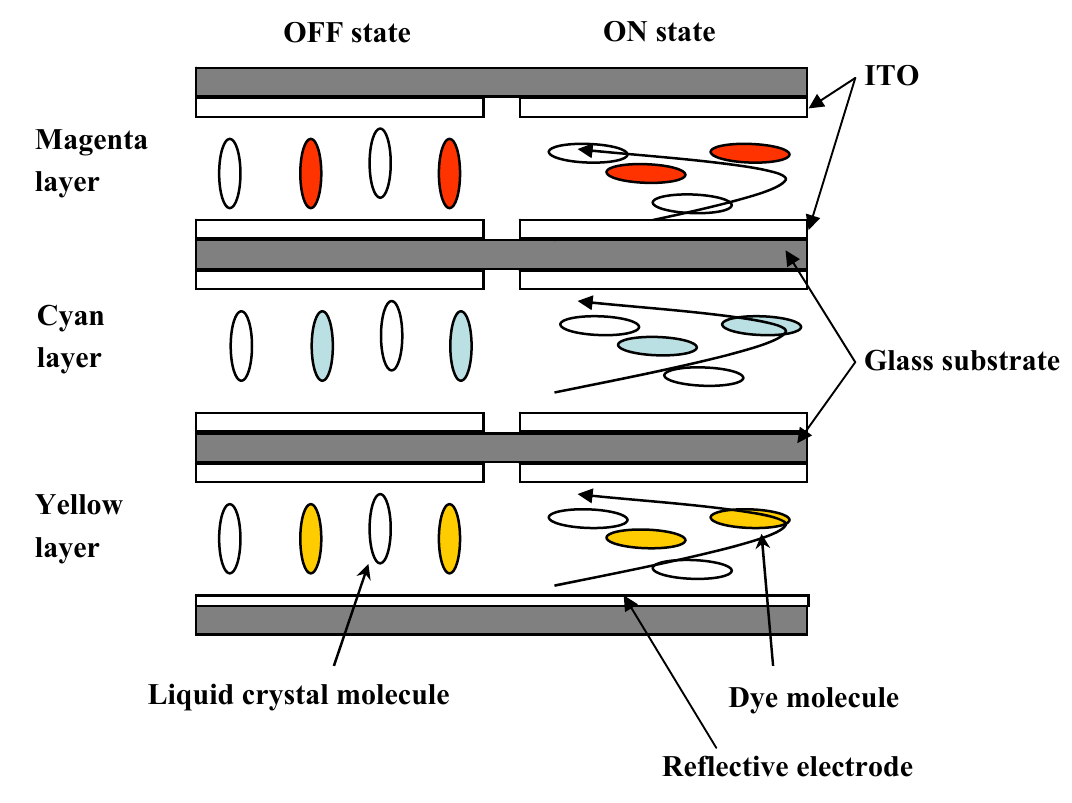
Figure 2. The schematic structure of the three-layer reflective GH-LCD using negative liquid